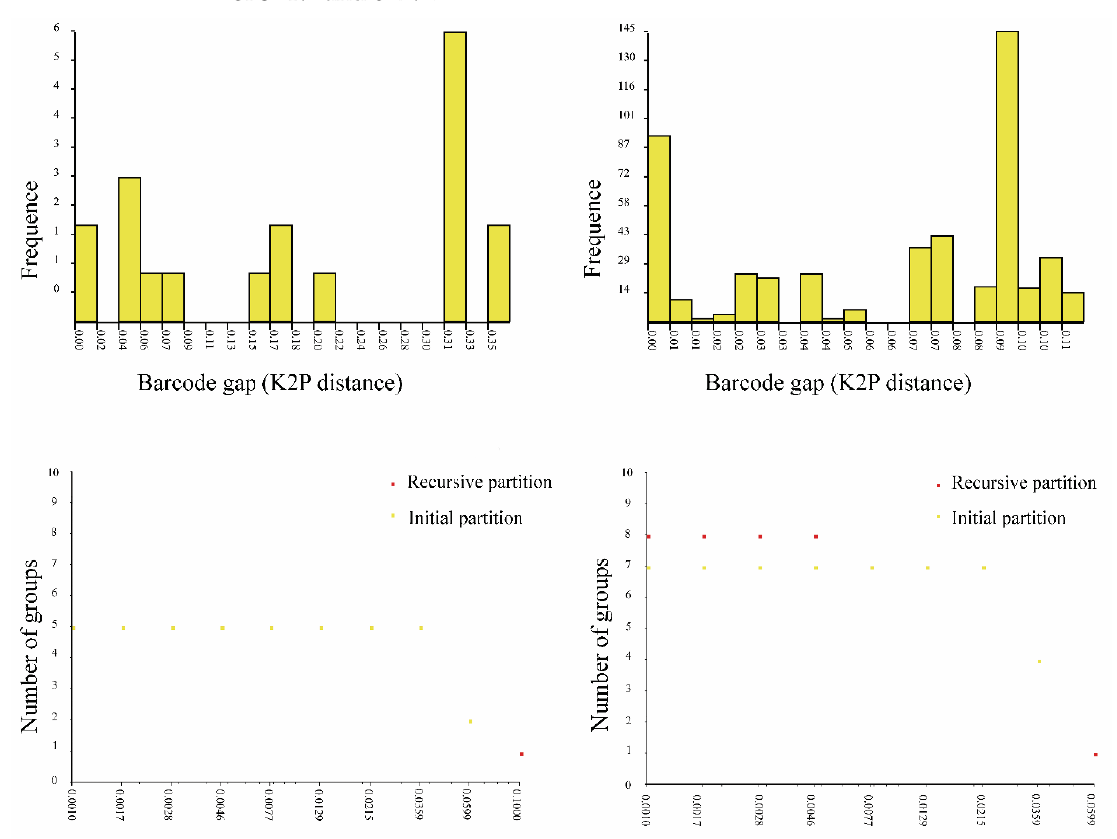
Figure 29. ABDG delimitation of Geckobia species: ( a ) COI gene; ( b ) 28S gene. Genetic distance of COI within the genus Geckobia was much higher than the genetic distance of D2 of 28S rRNA fragment (Table 5). The COI genetic distance between genera Geckobia and Pimeliaphilus was higher (35.6, SD = 0.02) than between Geckobia and Ptery- gosoma (32.5, SD = 0.02), whereas the D2 of 28S rRNA fragment shows that the genetic distance between the former genera was lower (32.6, SD = 0.02) than between the latter genera (40.2, SD = 0.02).